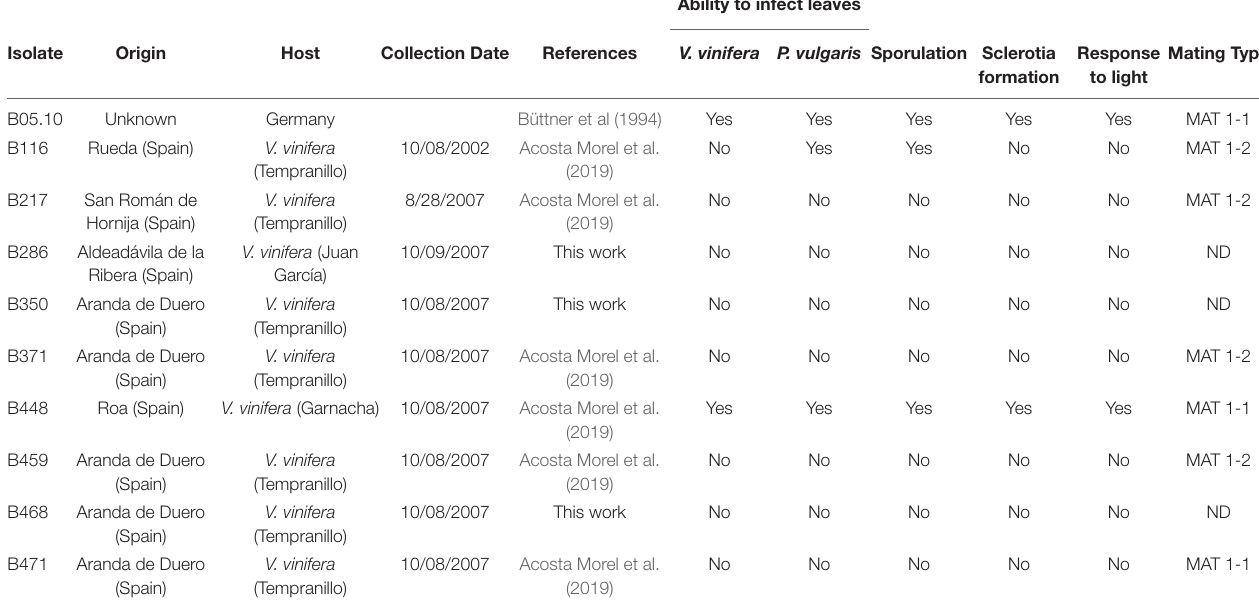
Ability to infect